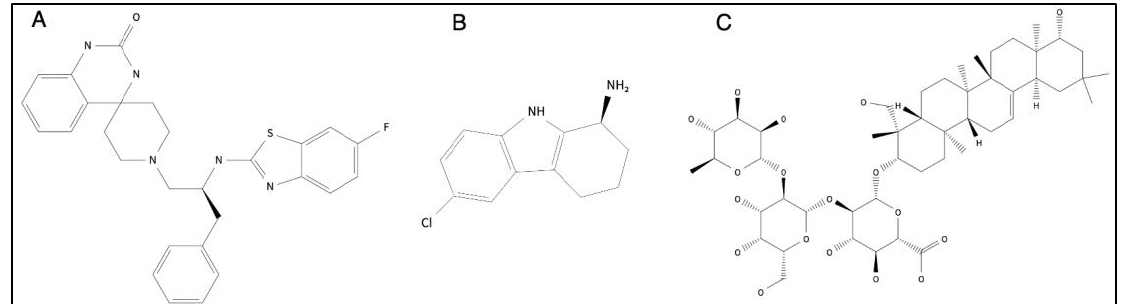
Figure 9. The structure of compounds regulating zinc transporters. ( A ) A ZIP7 inhibitor (NVS-ZP7- 4) regulates ER zinc levels and Notch signaling (IC 50 = 0.13 μM). ( B ) A ZIP8 inhibitor regulates intracellular zinc level (IC 50 = 17.2 μM). ( C ) Soyasaponin Bb, extracted from soybeans, increased intracellular zinc level (IC 50 = 17.2 µ M). ( C ) Soyasaponin Bb, extracted from soybeans, increased ZIP4 expression.